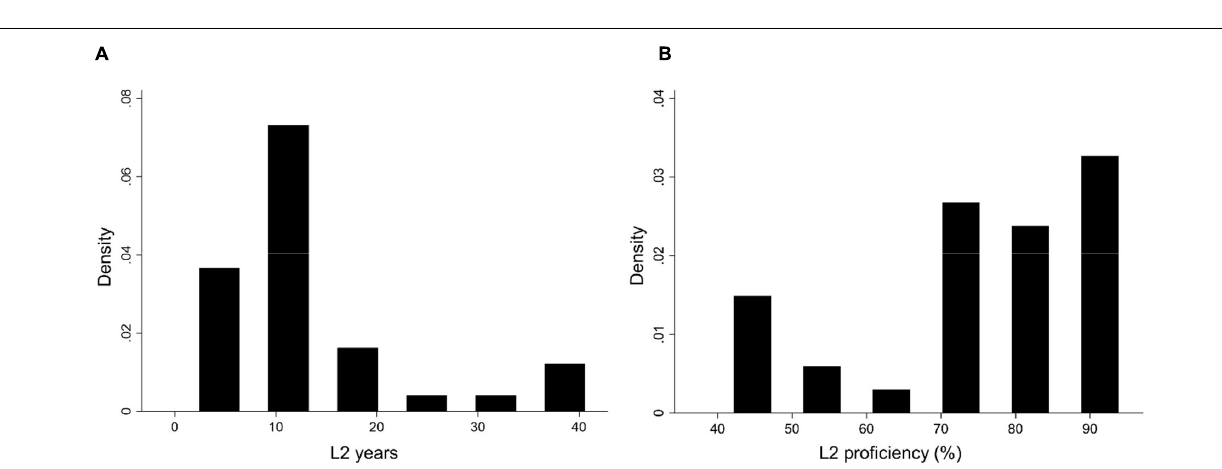
FIGURE 2 | Histograms of the distribution of (A) number of years passed since L2 was acquired (L2 years) and (B) L2 proficiency in the L2-English